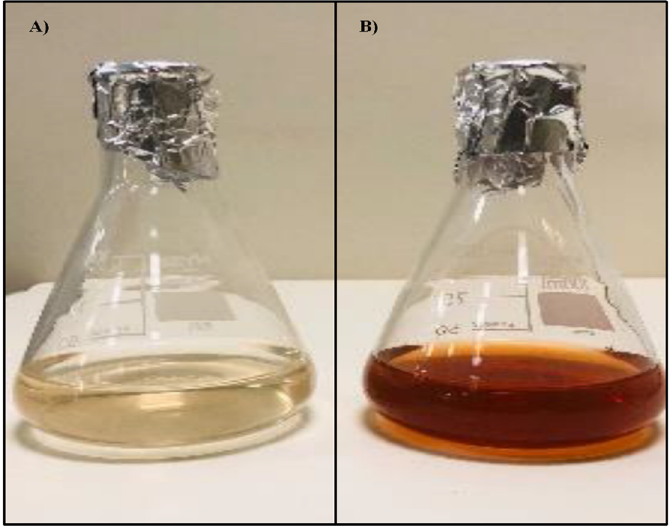
Figure 1. Physical biosynthesis of GSE-AgNPs. GSE-AgNPs were prepared by boiling with an aqueous solution of AgNO 3 (1 mM), which turned it from light-yellow into brownish-yellow. ( A ) GSE, ( B ) GSE-AgNPs.